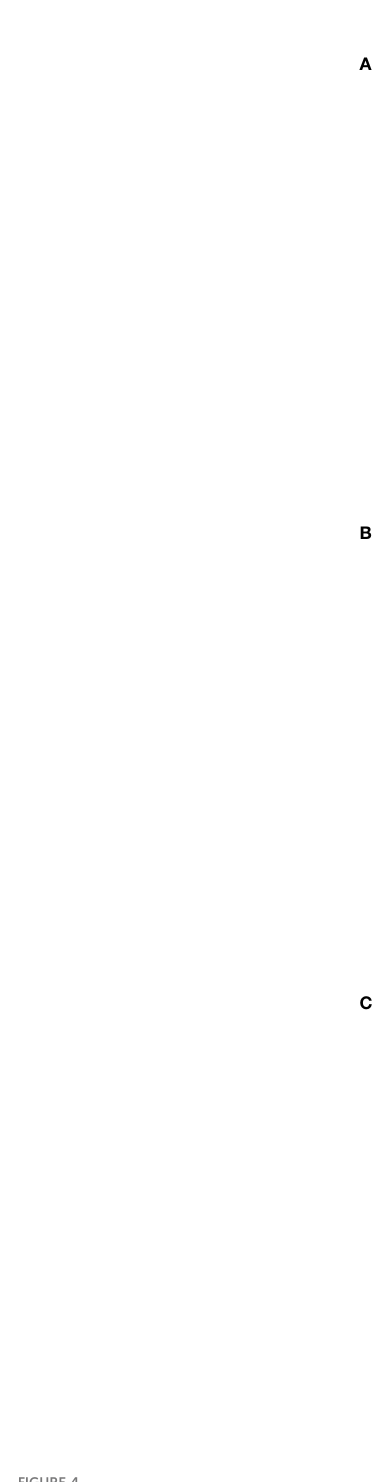
FIGURE 4 Heatmaps and dendrogram. Colored bar on the left side indicating delta CD4+ T-cell increase 12 months after initiating cART; brown <50 cells/ µL, purple 50-99 cells/µL, green 100-199 cells/µL, red 200-300 cells/µL, blue >300 cells/µL, white: missing data. (A) Stimuli: LPS, (B) Stimuli: R848, (C) Stimuli: Poly